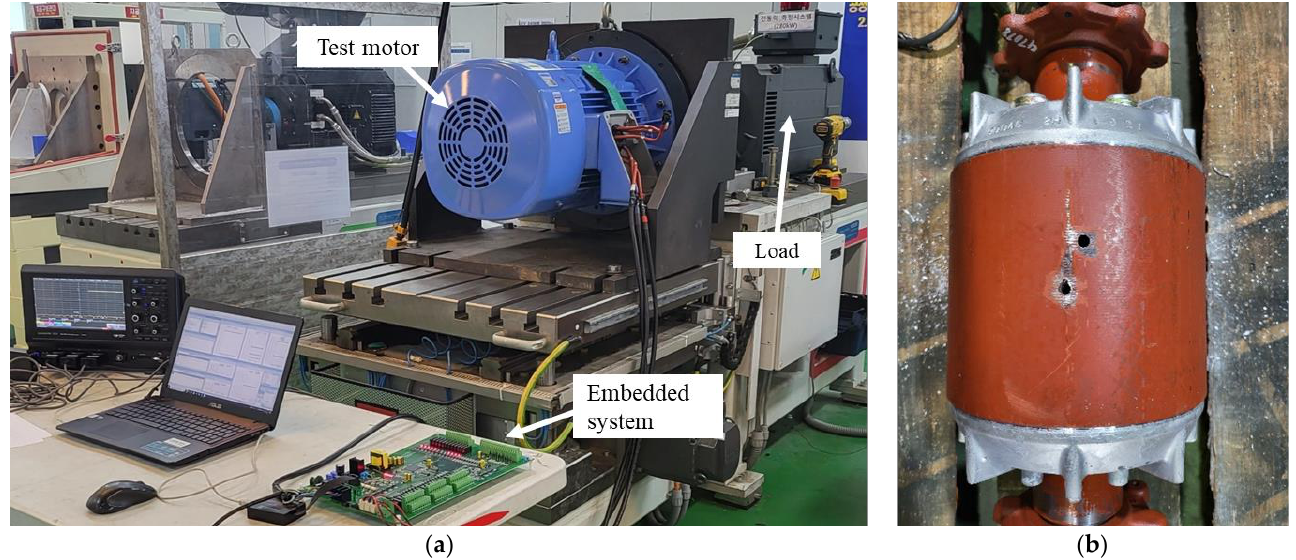
Figure 3. 55 kW 2-pole induction motor BRB fault diagnosis test environment and rotor with BRB fault.